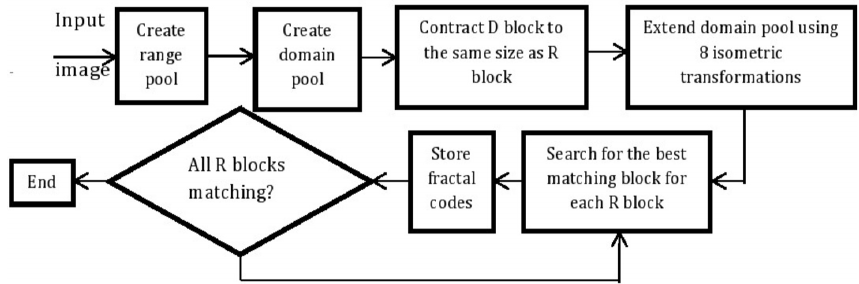
Figure 32. Encoding